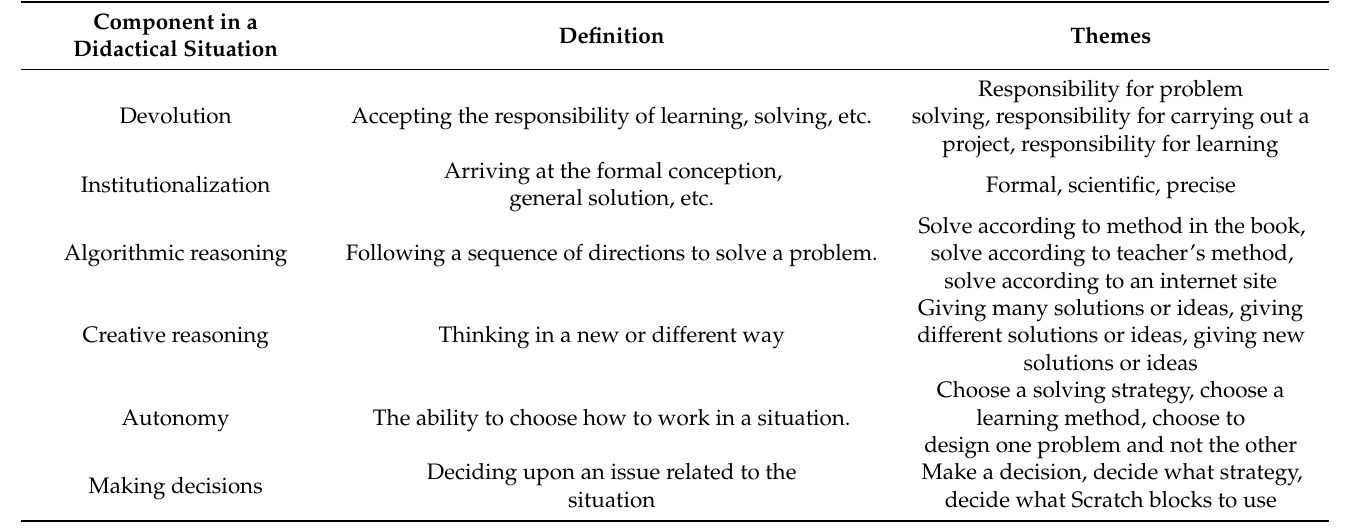
Table 3. Categories of didactical situation components, their definition, and their